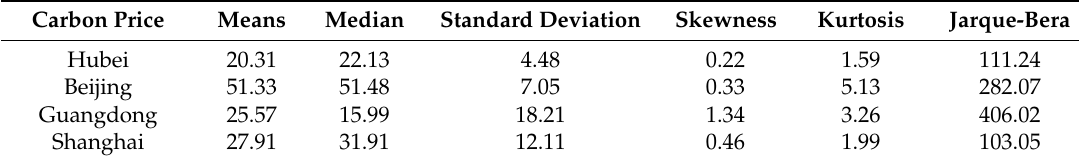
Table 2. Statistical descriptions of the carbon price.